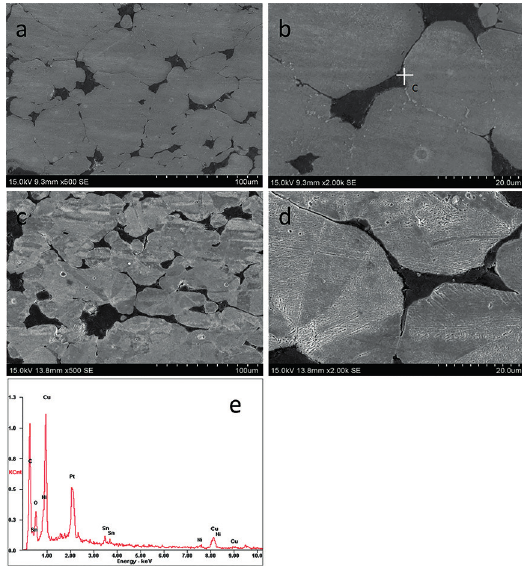
Figure 4: SEM images: (a) and (b) Ni containing graphite-CuSn10 composite layers with 10 vol% graphite, (c) and (d) no Ni containing graphite-CuSn10 composite layers with 10 vol% graphite, (e) EDS pattern of point C in Fig.